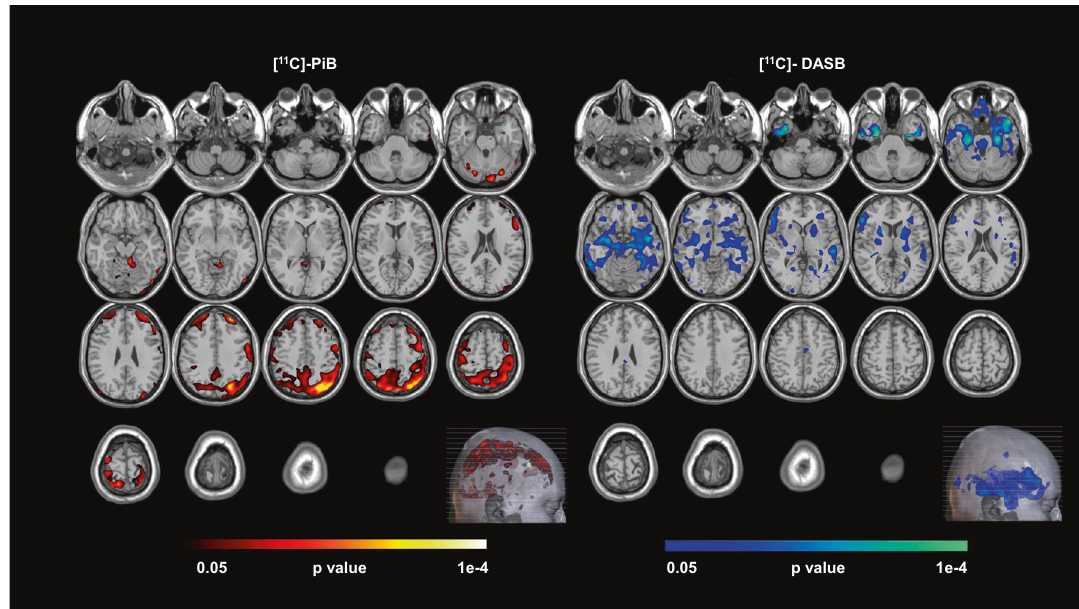
Fig. 1 Voxel-wise, statistical parametric mapping (version 12) unimodal analysis for [ 11 C]-PiB and [ 11 C]-DASB, separately. Higher beta- amyloid (left, hot colored areas) and lower serotonin transporter availability (right, cool colored areas) was observed in Late-Life Depressed (LLD) Patients than in normal controls, applying the Monte-Carlo Simulation Method (uncorrected P = 0.005).